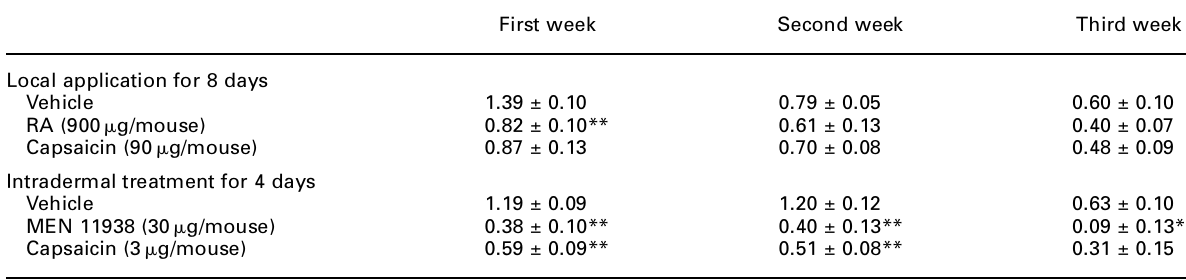
Table 1. Paw oedema induced by Freund’s adjuvant in mice. Animals were treated by local application of ricinoleic acid (RA; 900 m g/mouse) or capsaicin (90 m g/mouse) for 8 days or intradermally administered for 4 days with MEN 11938 (30 m g/mouse), the potassium salt of RA, or capsaicin (3 m g/mouse). The paw oedema was measured once a week after the injection of Freund’s adjuvant